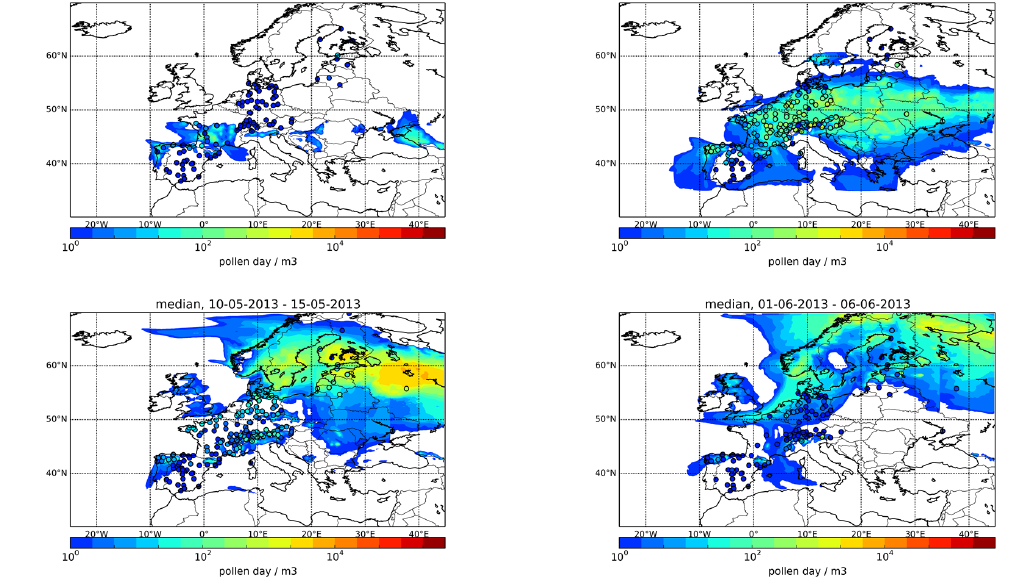
Figure 5. Season progression, ensemble median, and observations: 5-day mean pollen concentrations (pollenm − 3